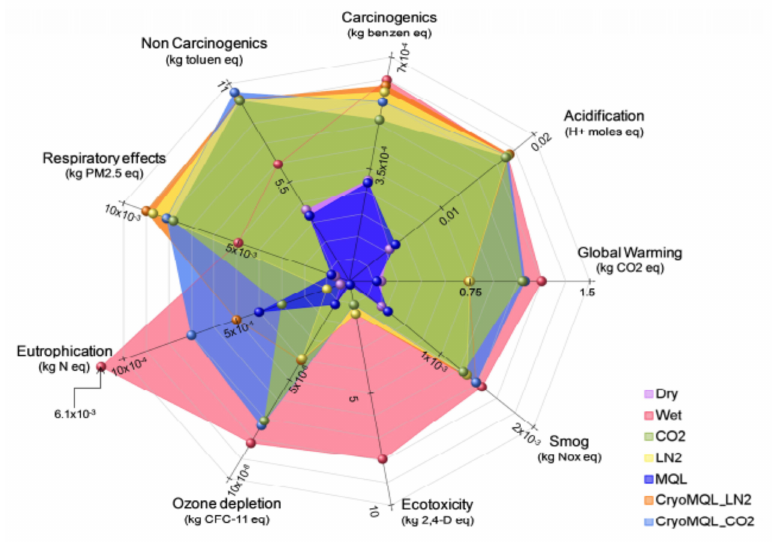
Figure 13. The impact on the environment by different cooling techniques, reprinted with permission from ref. [67]. Copyright 2016 Elsevier Ltd.